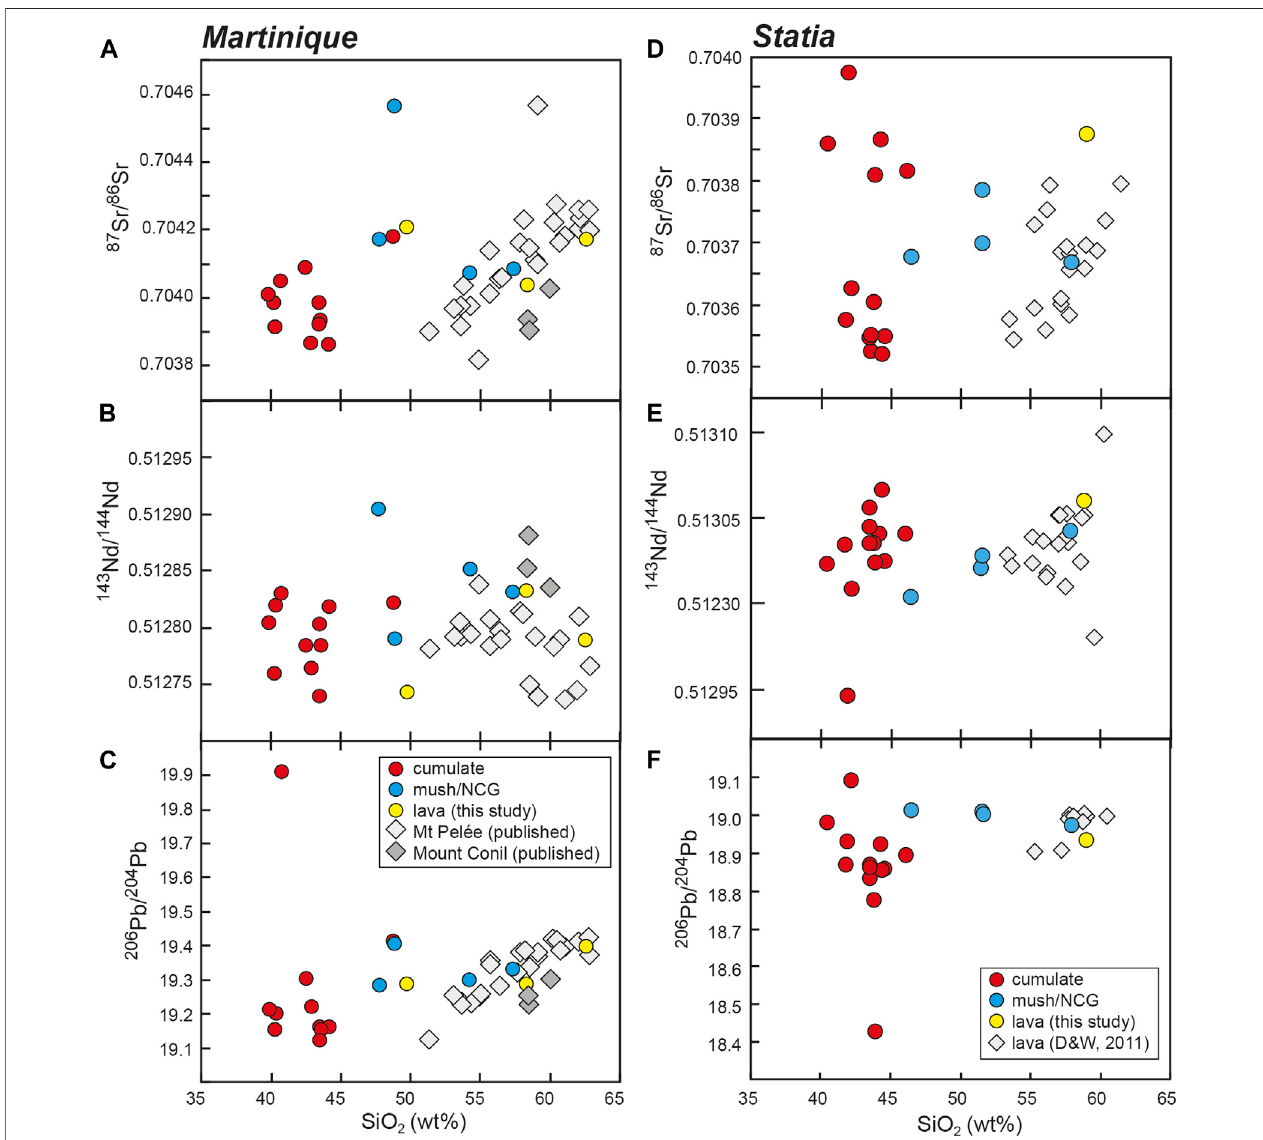
FIGURE3| Radiogenicisotopes( 87 Sr/ 86 Sr, 143 Nd/ 144 Ndand 206 Pb/ 204 Pb)versusSiO 2 (wt%)ofwhole-rocksamples(coloured circles) fromMartinique (A – C) and Statia (D – F) analysed in this study (Martinique data originally published in Brown et al., 2021).